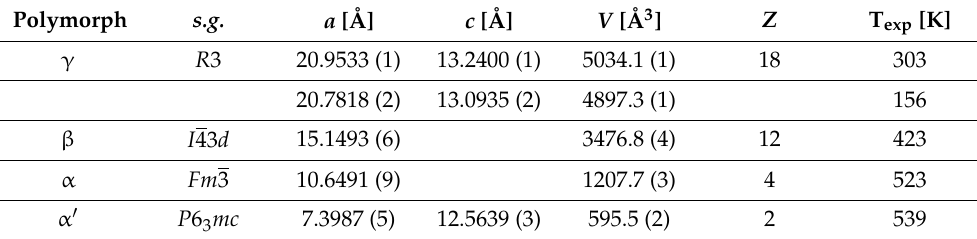
Table 1. Thermal polymorphs observed in anhydrous CsCB 11 H 12 with their space group symmetry ( s.g. ), lattice parameters, cell volume, and the number of formula units ( f.u. )/unit cell ( Z ). The naming of the polymorphs is according to ref.